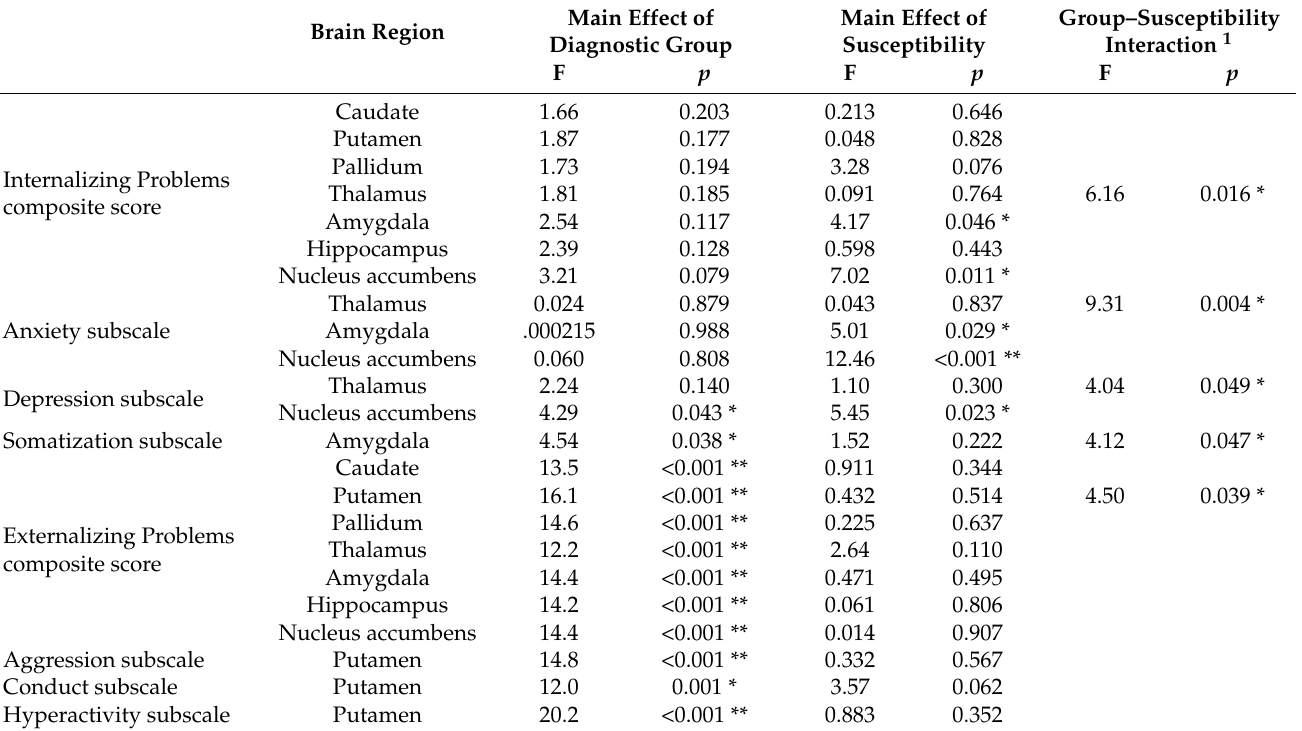
Table 5. Associations between susceptibility and mental health symptoms in brain regions. Internal- izing and Externalizing subscales were only assessed in brain regions with a significant main effect of susceptibility or a group–susceptibility interaction for Internalizing or Externalizing composite scores.